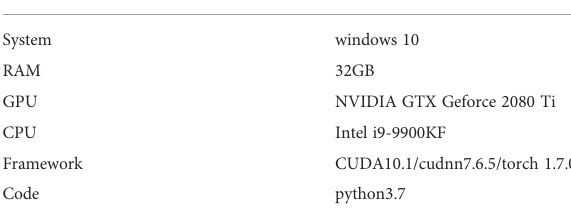
TABLE 2 Environment Con fi